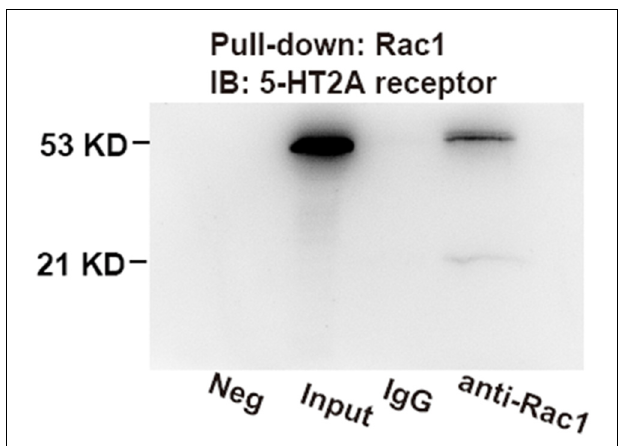
FIGURE 4 | Co-immunoprecipitation (IP) assays demonstrated the interactions between hippocampal 5-HT2A receptors and Rac1. Rac1 was pulled down using anti-Rac1 antibody; 5-HT2A receptors were measured on immunoblots. Bands at 53 kDa were detected in input and Rac1 pull-down lane, which were not detected in the immunoglobulin G (IgG) lane, and a weak positive band around 21 kD was detected in the Rac1